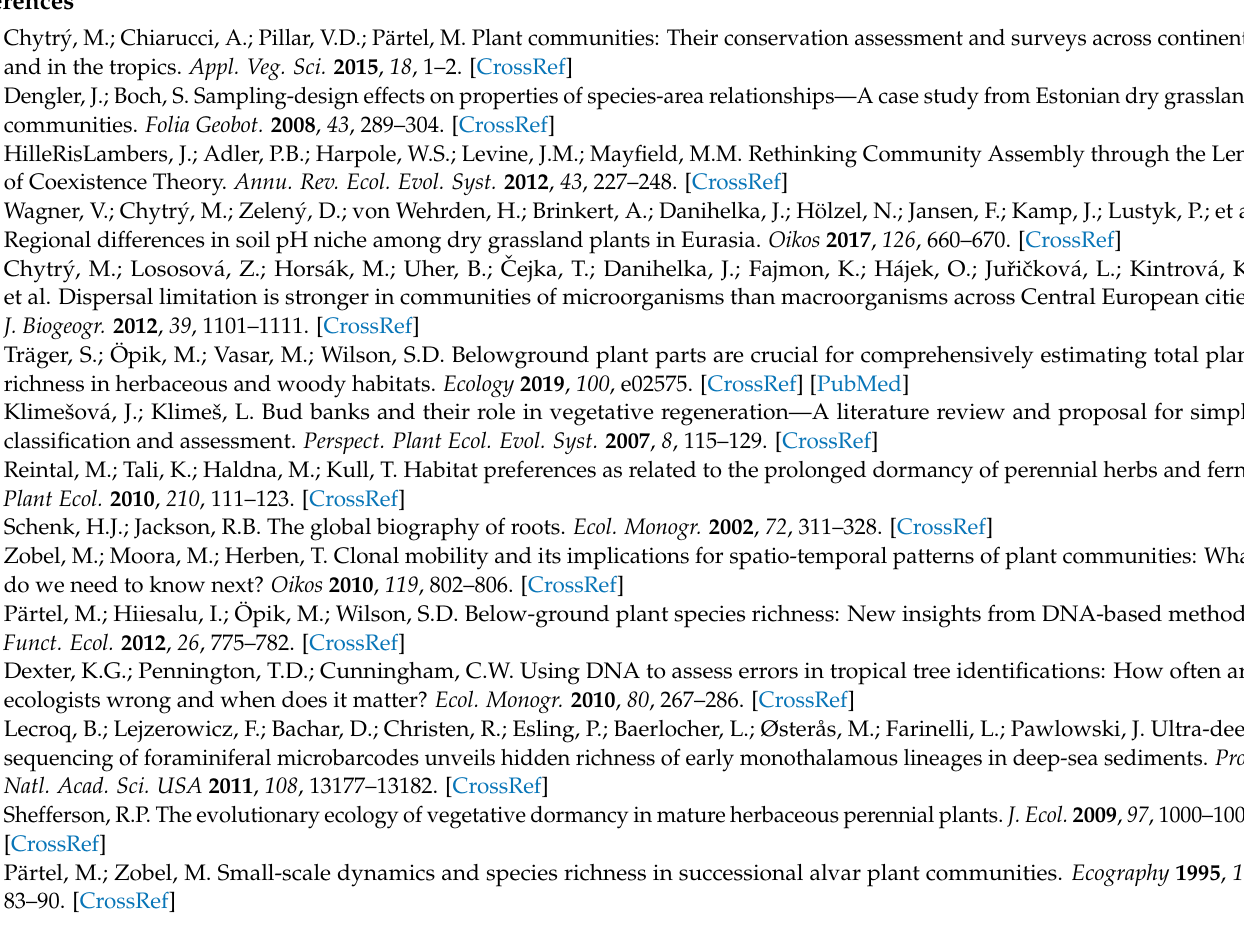
A260–A230 for all predictors of simplified BRT model; Figure S2: Partial dependence plots showing the marginal relationships of belowground DNA quality shown as ratio A260–A280 for all predictors of simplified BRT model; Figure S3: Partial dependence plots showing the marginal relationships of belowground DNA concentration for all predictors of simplified BRT model; Figure S4: Partial dependence plots showing the marginal relationships of aboveground DNA quality shown as ratio A260–A230 for all predictors of simplified BRT model; Figure S5: Partial dependence plots showing the marginal relationships of aboveground DNA quality shown as ratio A260–A280 for all predictors of simplified BRT model; Figure S6: Partial dependence plots showing the marginal relationships of aboveground DNA concentration for all predictors of simplified BRT